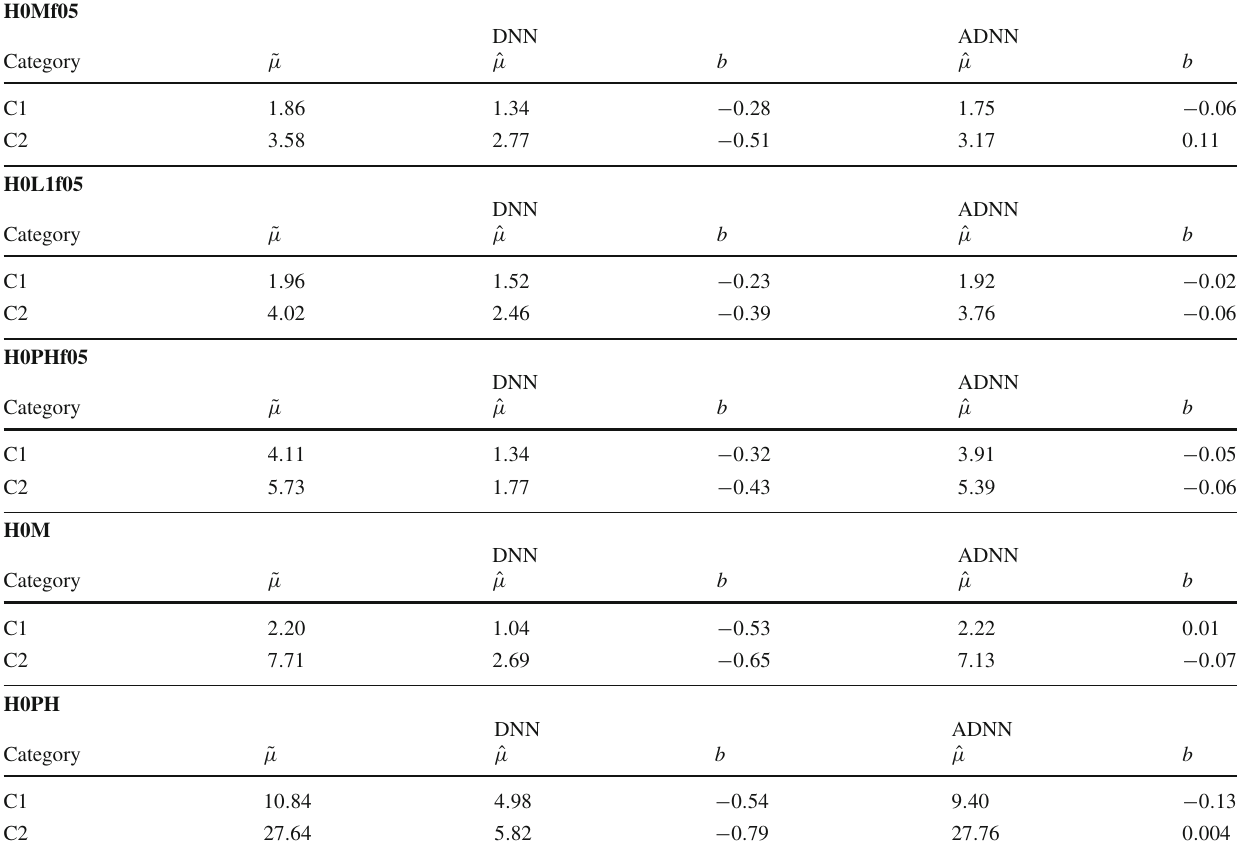
Table 5 Expected and measured signal strength and bias quantities evaluated on the Asimov data set corresponding to each BSM hypothesis with both the DNN and the ADNN